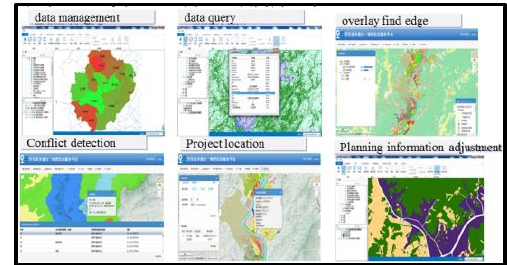
Figure 3.Interface of information of